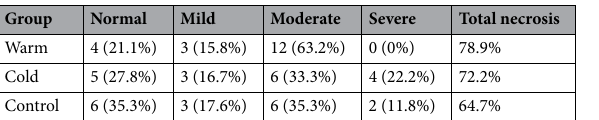
Figure 6. Observation indexes and histopathological changes in 3 groups at 7 days after intravascular injection. ( a ) Percentage of vascular recanalization in different groups 7 days after intravascular injection. ( b ) Incidence of cord-like induration in different groups 7 days after intravascular injection. ( c ) Percentage of different embolisms in different groups 7 days after intravascular injection. ( d ) Histopathological changes 7 days after intravascular injection (H&E stanning). i: arrow: red thrombus composed of red blood cells and light red amorphous substances; ii: arrow: white thrombus composed of a large number of PMMA microspheres; iii: arrow: PMMA microspheres; iv: ulceration; v: erythema, arrow: inflammatory cell infiltration. vi: arrow: small amount of subcutaneous red blood cell infiltration; vii: arrow: severe hematoma. Scale bar: 100 μm. Figure was created in Adobe Illustrator software (version 22.1; https:// www. adobe. com/ produ cts/ illus trator. html) and GraphPad Prism software (version 9.4.1; https:// www. graph pad. com/ scien tific- softw are/ prism/).